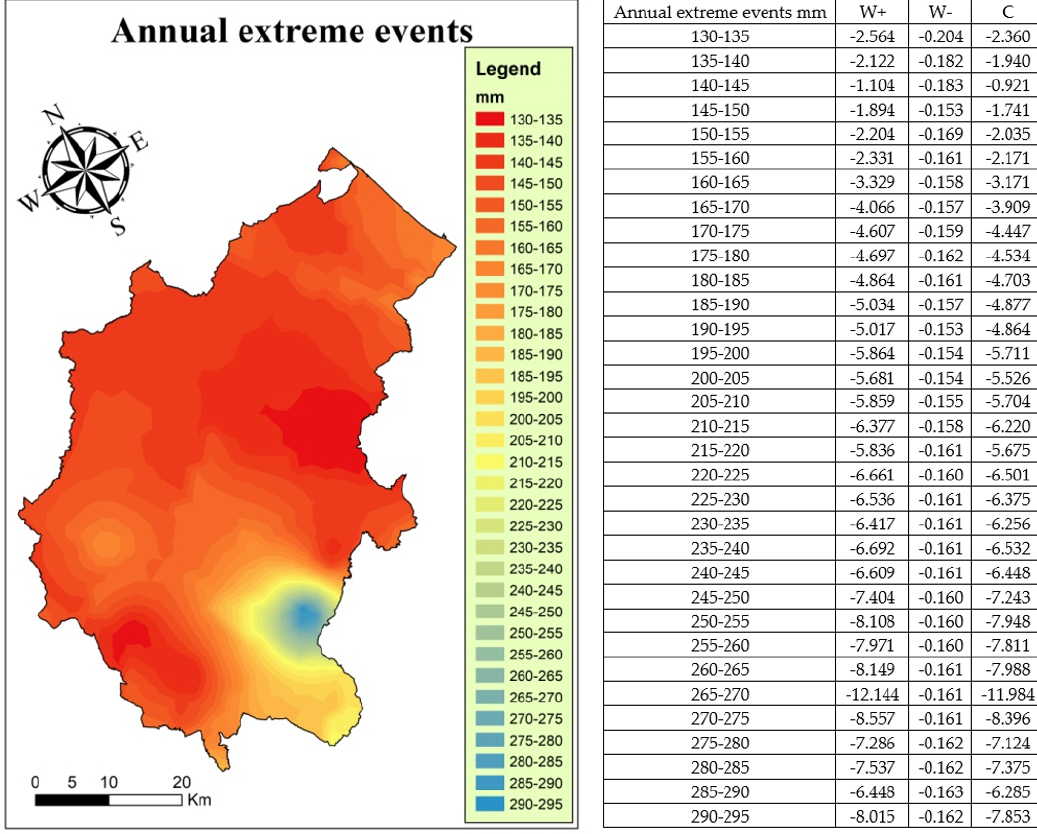
Figure 9. ( Left ) Annual extreme events of the Macerata Province; ( Right ) The weights calculated for extreme events pa- rameter.